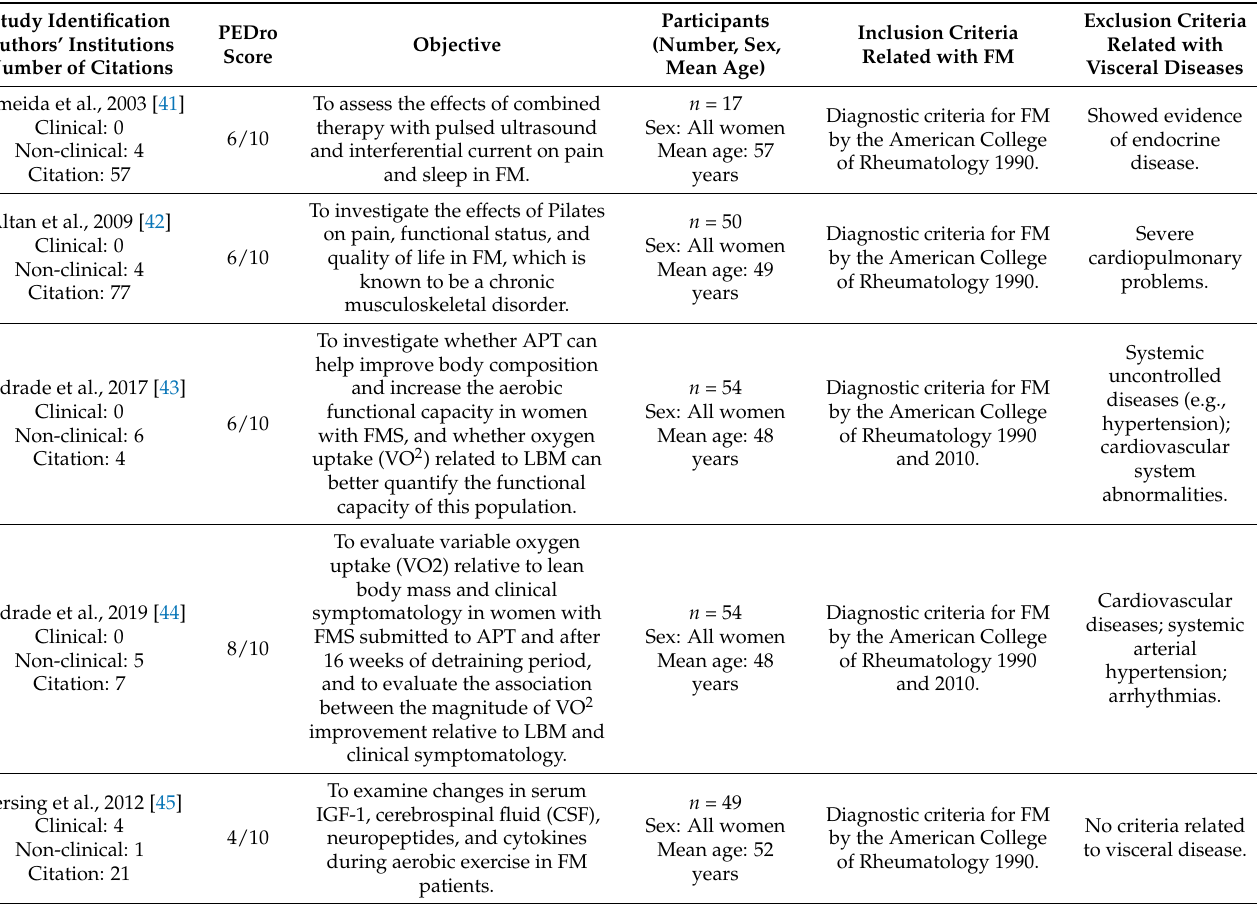
Table 2. Clinical trials evaluating the effects of physical therapy in FM fulfilled the Q1-JCR criterion only ( n =